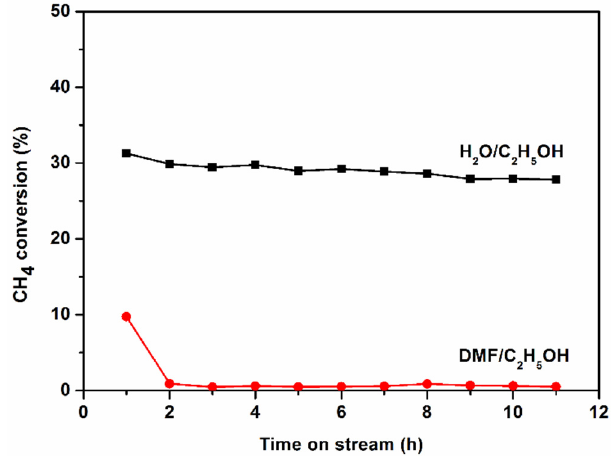
Figure 4. Methane conversion of the catalysts prepared with different solvents during the POM 10 h 750 ◦ C and a gas flow rate of 800 mL · min − 1 . at 750 °C and a gas flow rate of 800 mL·min − 1 .